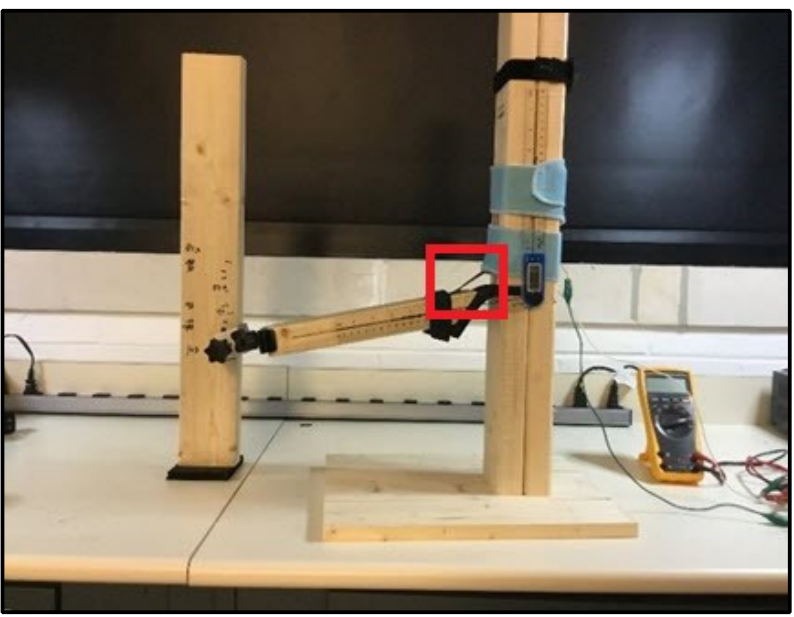
Figure 6. Ankle model prototype; SRS is highlighted in red.